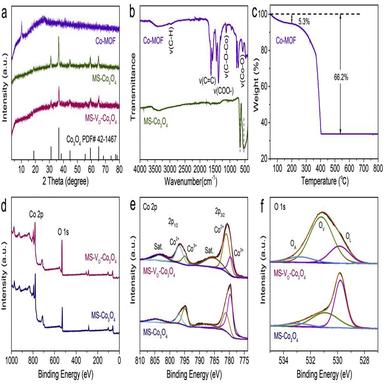
(a) XRD patterns of the Co-MOF, MS-Co3O4 and MS-VO-Co3O4. (b) FTIR spectra of Co-MOF and MS-Co3O4. (c) TGA curve of Co-MOF precursor. XPS analysis of the MS-Co3O4 and MS-VO-Co3O4: (d) survey spectra, (e) Co 2p and (f) O 1s.